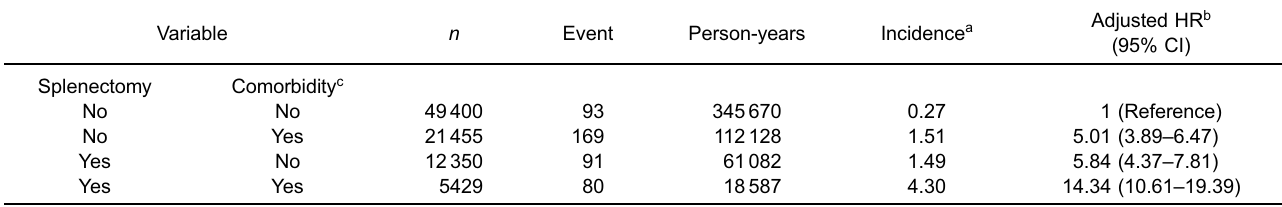
Table 4. Interaction effect on pyogenic liver abscess between splenectomy and other